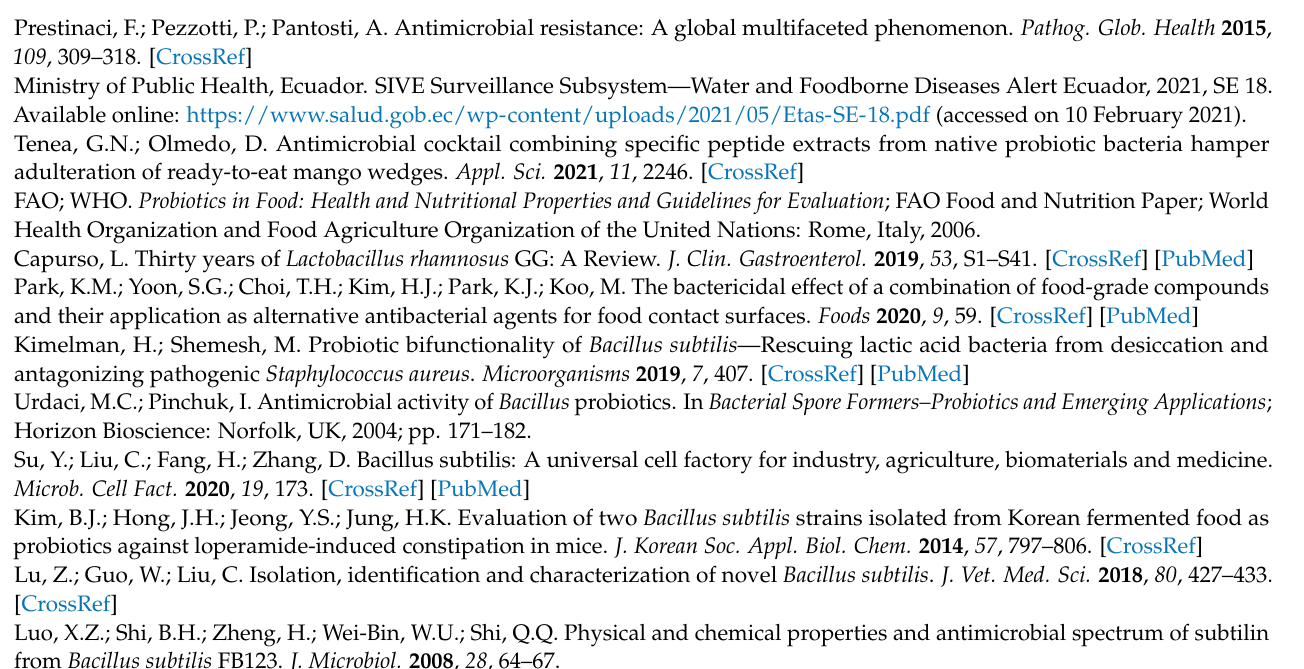
10.3390/microorganisms10050860/s1, Table S1. Cell viability (log CFU/mL) registered during incuba- tion with the gastric juice at different pH and 0.3% bile (w/v, oxgall). Table S2. The cell viability (log CFU/mL) was registered during incubation with NaCl at different concentrations and temperatures for 24 h. Table S3. Antibiotic susceptibility of the B. subtilis Fa17.2 Table S4. Diameter of the zone of inhibition (mm) produced by CE of Fa17.2 and LP in different media against S. aureus ATCC1026. Table S5. Diameter of the zone of inhibition (mm) produced by CE of Fa17.2 and LP in different media against E. coli ATCC25922. Table S6. Diameter of the zone of inhibition (mm) produced by CE of Fa17.2 and LP in different media enriched with different carbon sources against K. cowanii B2Sh1. Table S7. Diameter of the zone of inhibition (mm) produced by CE of Fa17.2 and LP in different media against S. dysenteriae